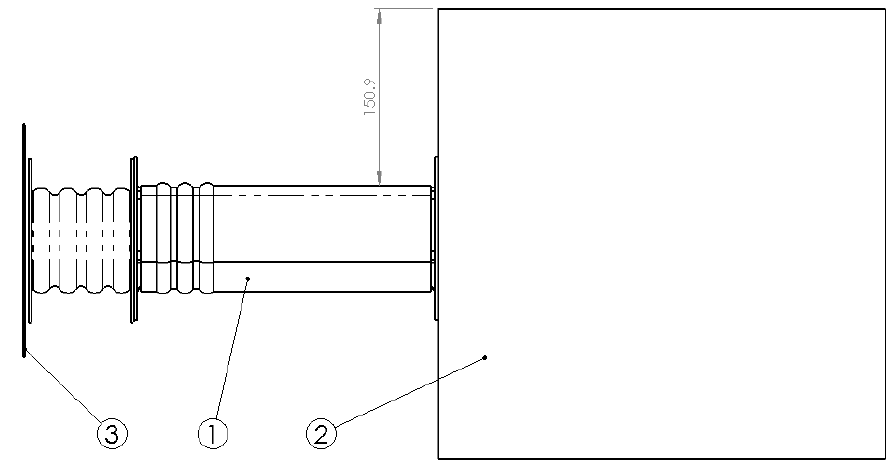
Figure 8. Side view of wall, front rail, ballast assembly.